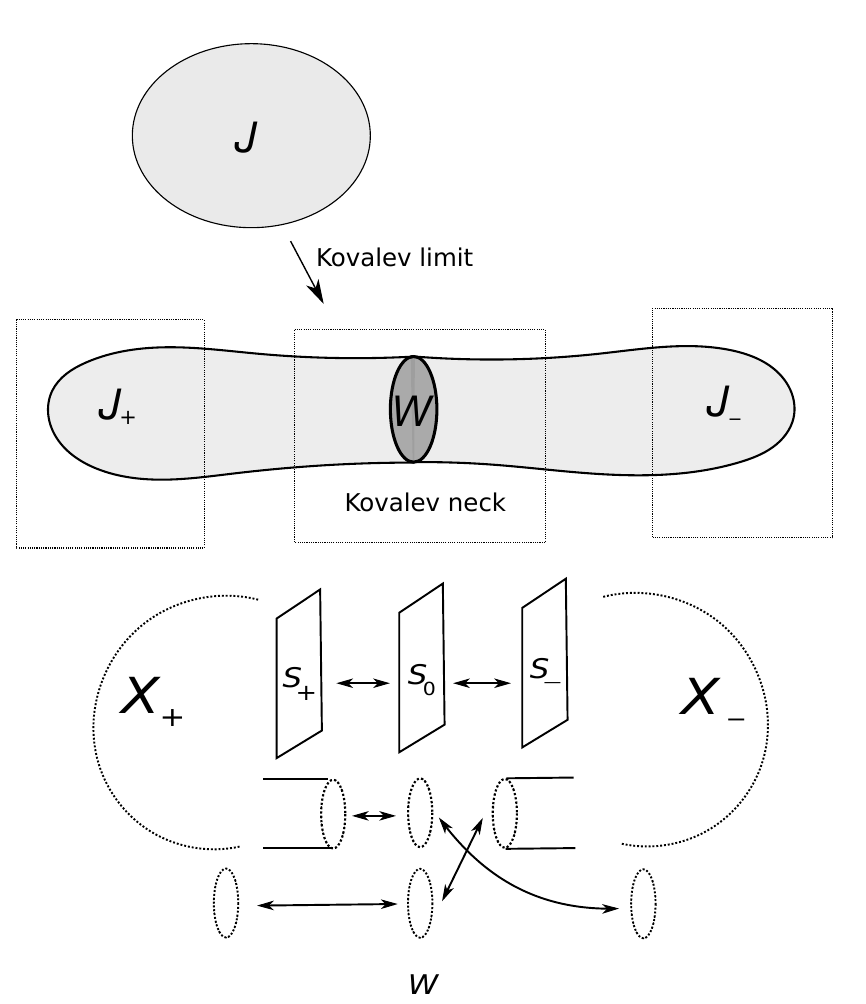
Figure 1 . A schematic description of the Kovalev limit for a G 2 manifold J . The K3 surfaces in the asymptotic cylinders of the two CYs X (cid:6) are denoted S (cid:6) . The K3 surface in W is denoted S 0